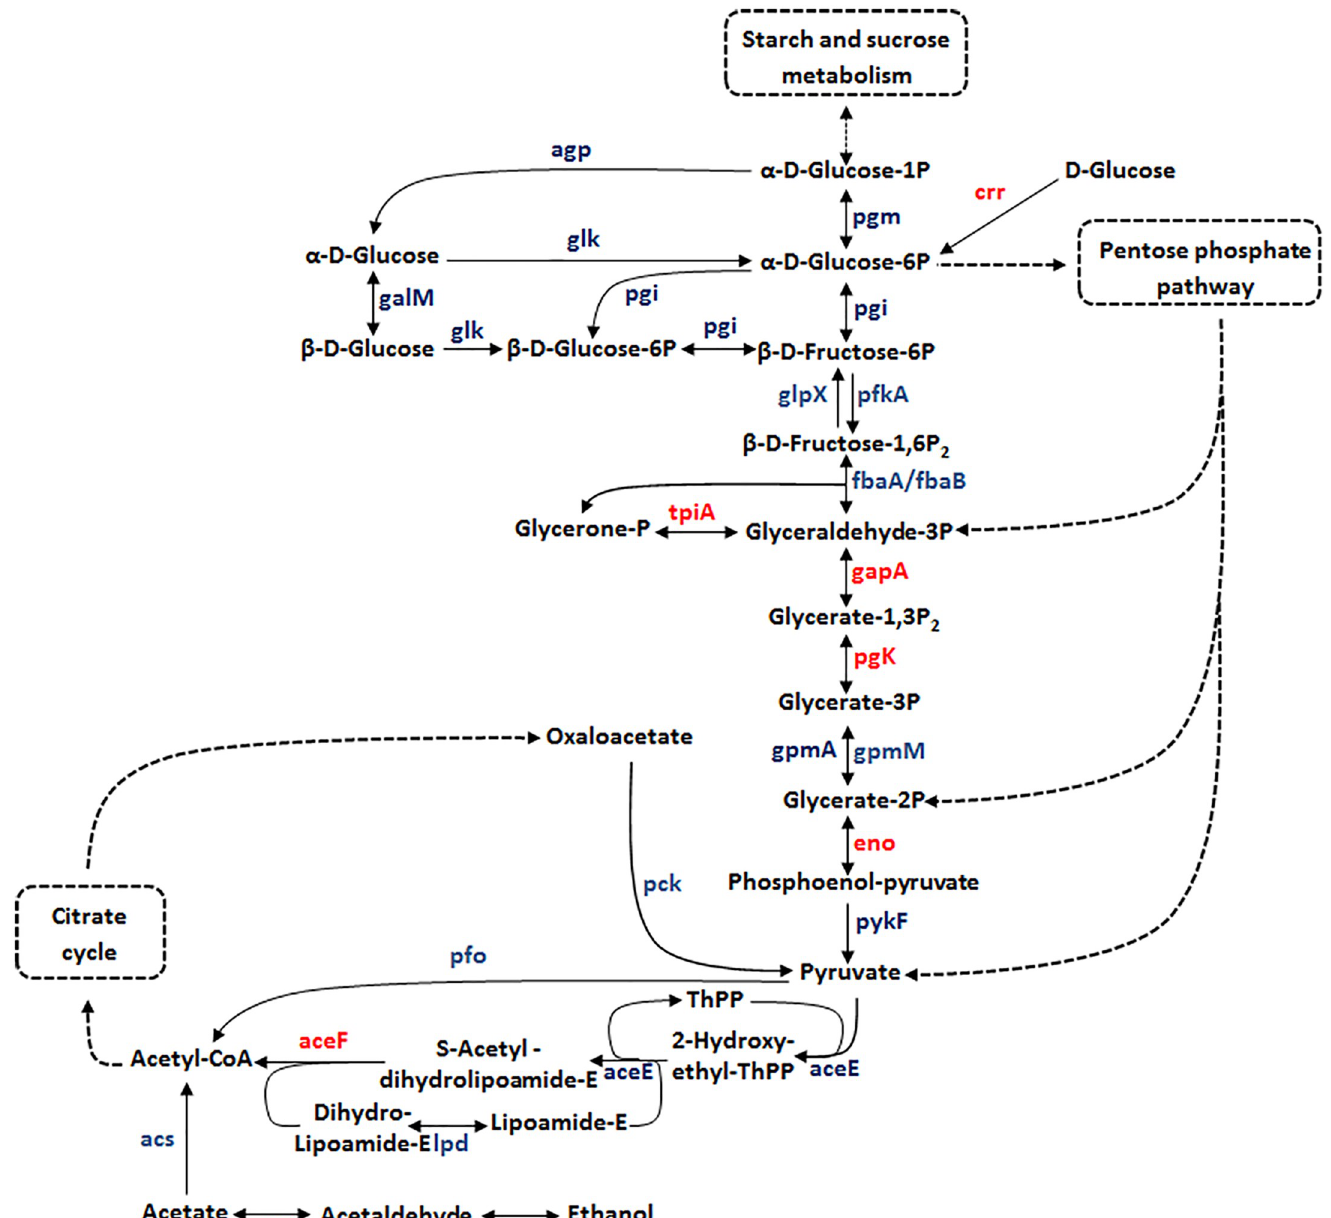
Fig 3. Overview of the glycolysis / gluconeogenesis pathway of EHEC O157:H7. Enzymes of the Glycolysis / Gluconeogenesis metabolism that were identified at the proteome level. Blue, proteins detected in our proteomic analysis; Green, proteins not identified in our study and Red, proteins detected as most abundant.